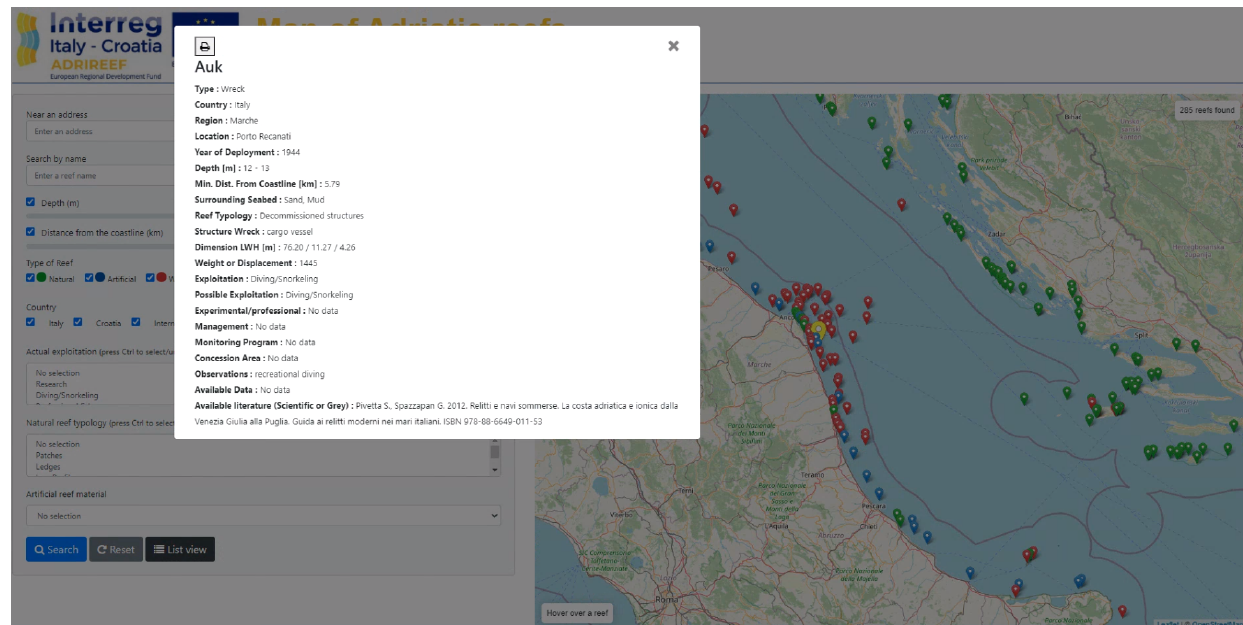
Figure 2. Example of the pop-up that appears once an element is clicked. Basemap credits: © OpenStreetMap contributors 2020. Distributed under a Creative Commons BY-SA